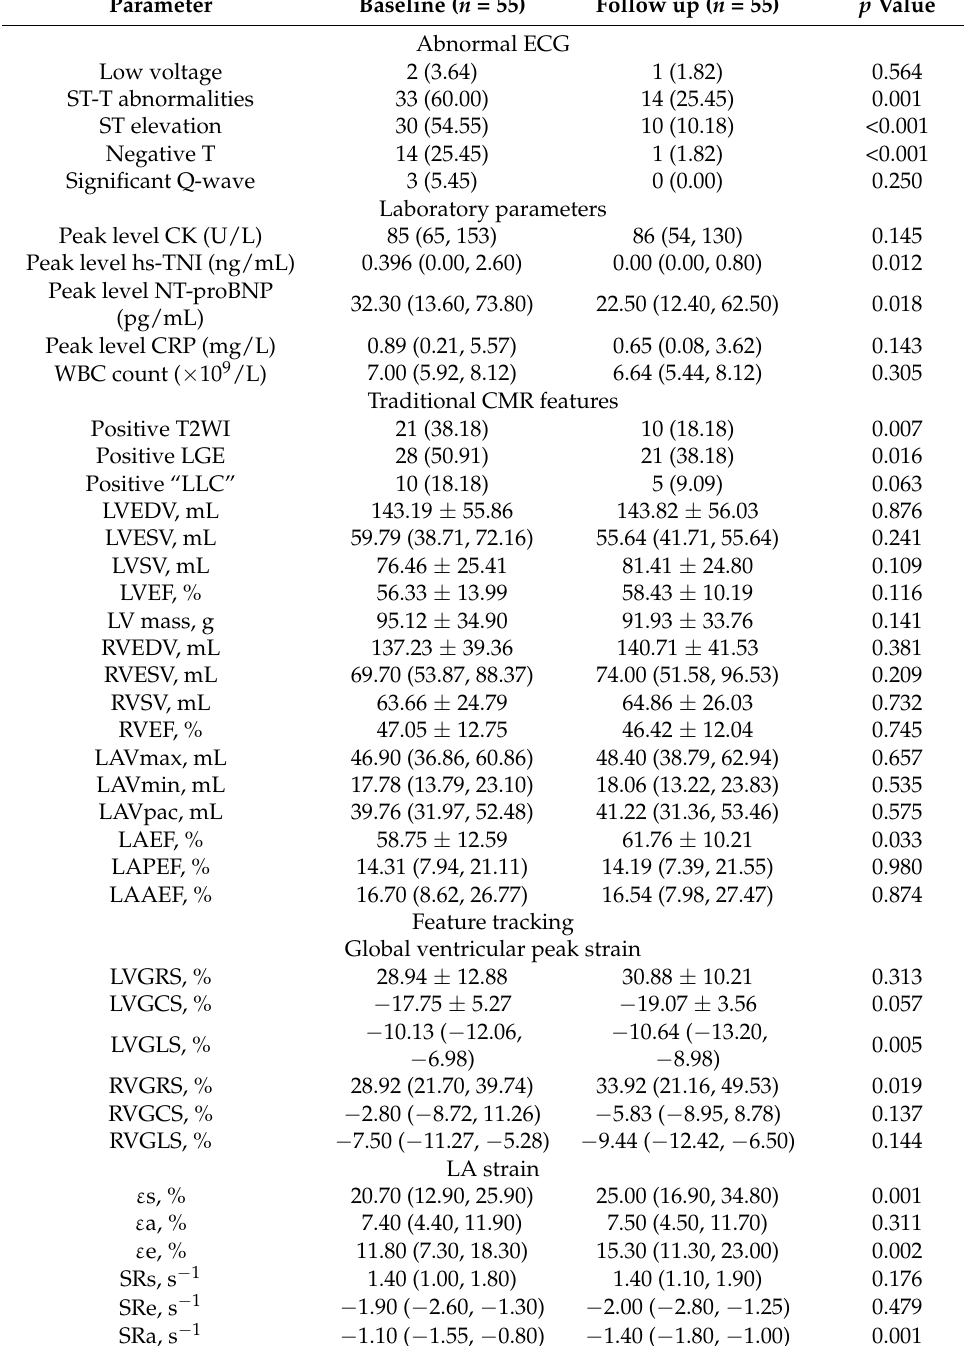
Table 2. Laboratory and CMR parameters of patients at baseline and follow